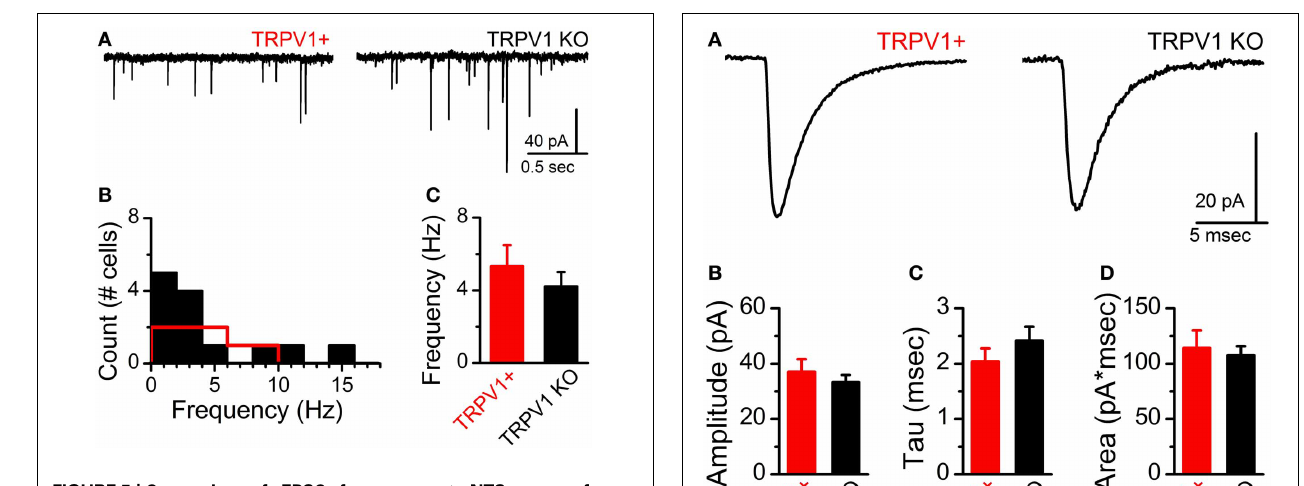
FIGURE 5 | Comparison of sEPSCs frequency onto NTS neurons from control (TRPV1 + ) and TRPV1 KO mice. (A) Current traces ( V m = − 60mV) of sEPSCs onto NTS neurons with each type of identified direct ST afferent contact. Temperature was held constant at 33 ◦ F. (B) Histogram of average sEPSC frequency across neurons (TRPV1 + : n = 8 neurons, red and TRPV1 KO: n = 13 neurons, black). (C) The distribution of sEPSC frequencies was not statistically different between neurons receiving TRPV1 + and TRPV1 KO contacts ( P = 0 . 57, unpaired t -test).